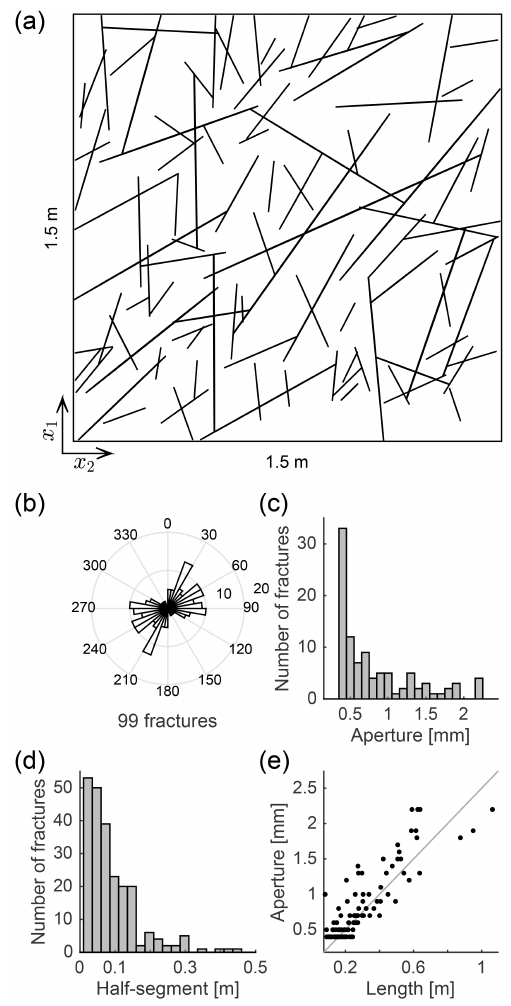
Figure 10. Geometry of the fractured rock example (a) , and the sta- tistical distribution of the orientations (b) , apertures (c) , segment half-lengths (d) and aperture–length cross plot with the gray line representing values for an aspect ratio of a 1 /a 2 = 400 (e) . Aper- tures are given as they were defined for zero lithostatic